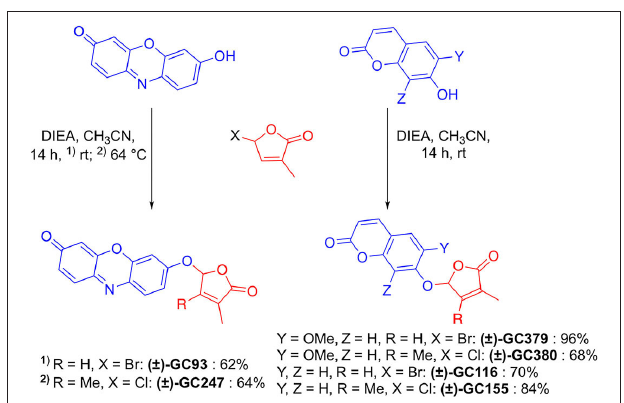
FIGURE 4 | Synthesis of novel profluorescent SL